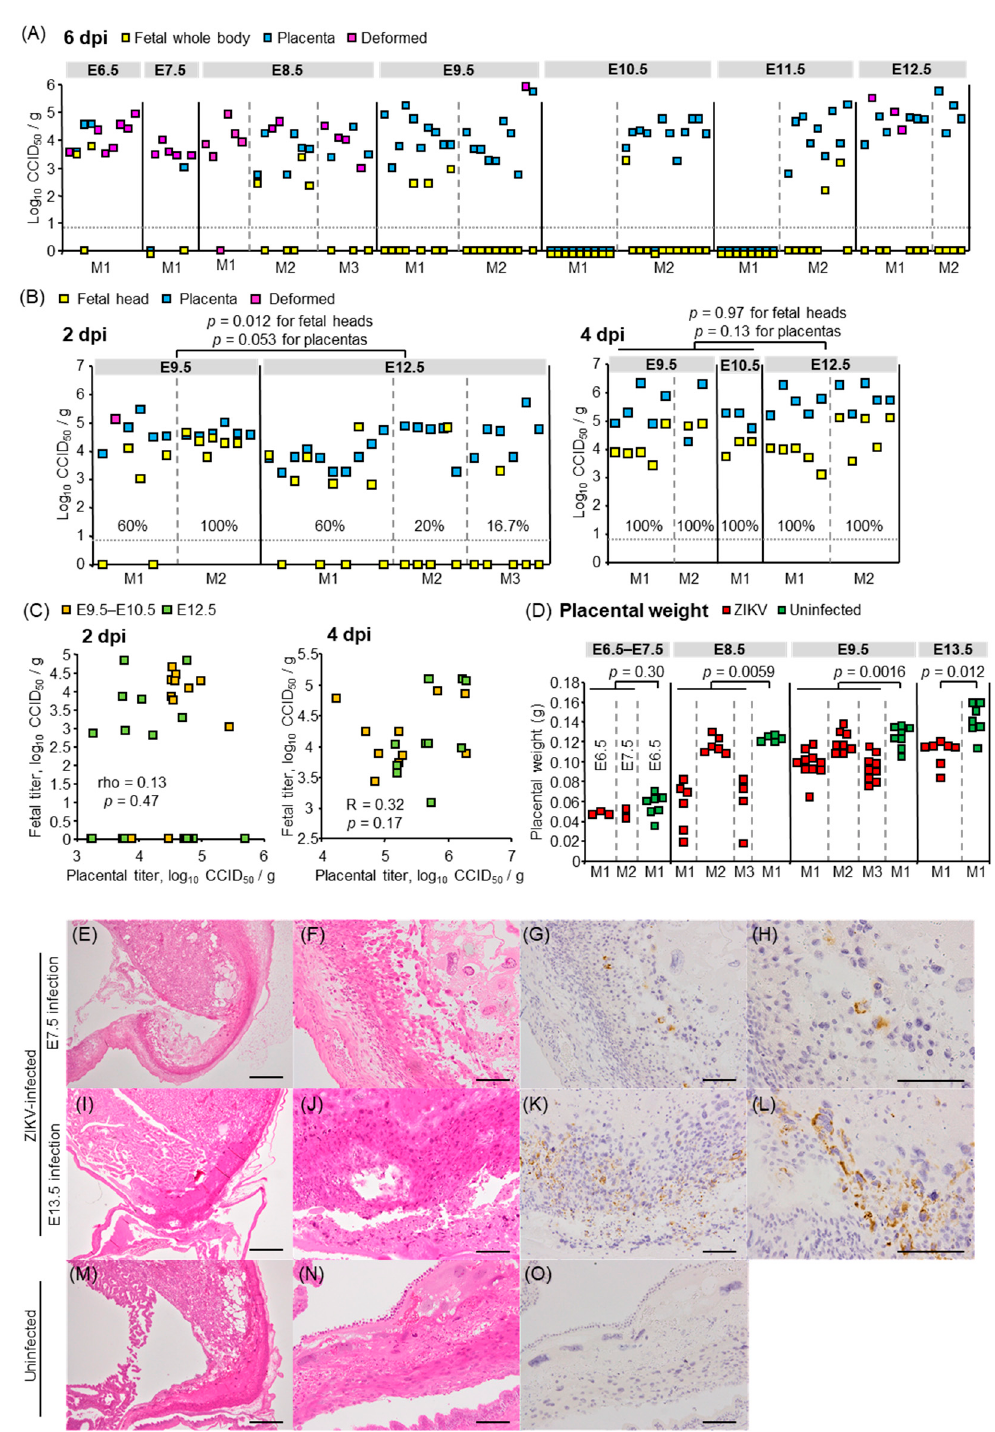
Figure 2. Viral titers and histological findings in fetal tissues or placentas. ( A ) Viral titers in fetal whole bodies, placentas, and deformed masses at 6 dpi. Dams were infected with ZIKV at the indicated embryonic days. Individual dams are indicated on the x -axis. Vertical dashed gray lines separate litters from each dam. Symbols represent individual fetus, placenta, or deformed mass. Limit of detection was 0.83 log 10 CCID 50 /g as indicated by the horizontal dashed line. ( B ) Viral titers in fetal heads, placentas, and deformed masses at 2 or 4 dpi, as described for panel A. Percentage of fetuses that were infected for each dam at 2 or 4 dpi is indicated. Kolmogorov–Smirnov test or t -test was used for statistical analysis. ( C ) Lack of correlation between virus titers in placentas and fetal heads at 2 dpi and 4 dpi as determined by Pearson or Spearman’s correlation test. ( D ) Placental weights at 6 dpi. Dams were infected with ZIKV or inoculated with 2MEM (uninfected) at the indicated embryonic days. Individual dams are indicated on the x -axis; each square represents one placenta. Significance was determined by t -test or Kolmogorov–Smirnov test. ( E ) H&E staining of placentas at 6 dpi;